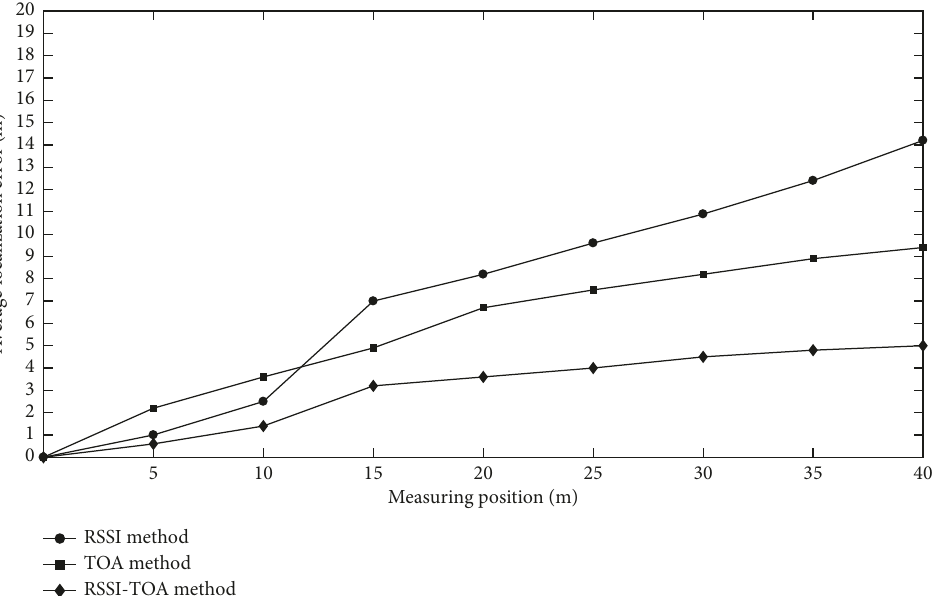
Figure 8: Relationship between localization error and measurement position.